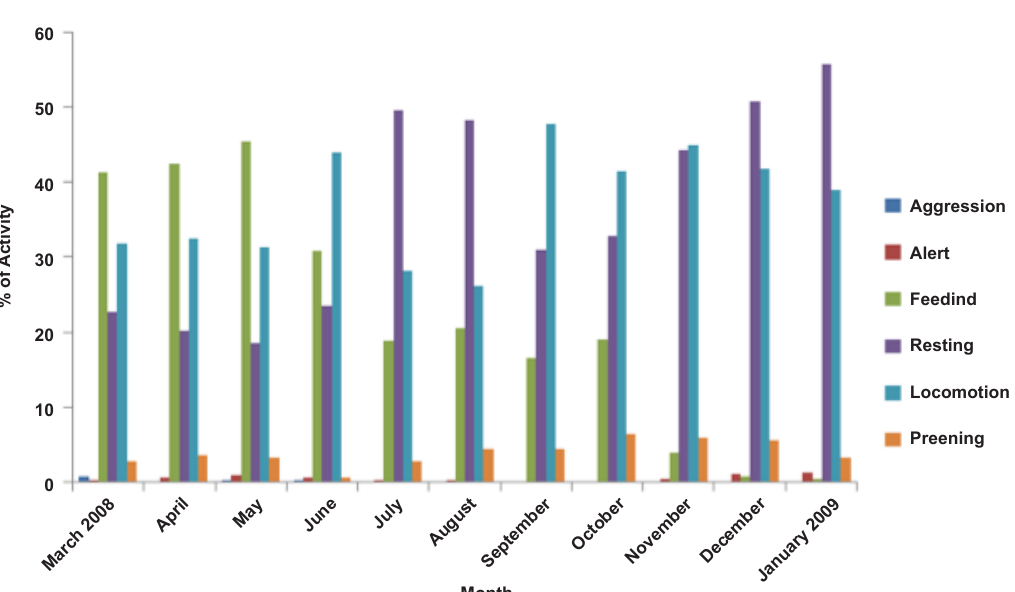
Figure 1. Diurnal activity budget (%) in Large Whistling